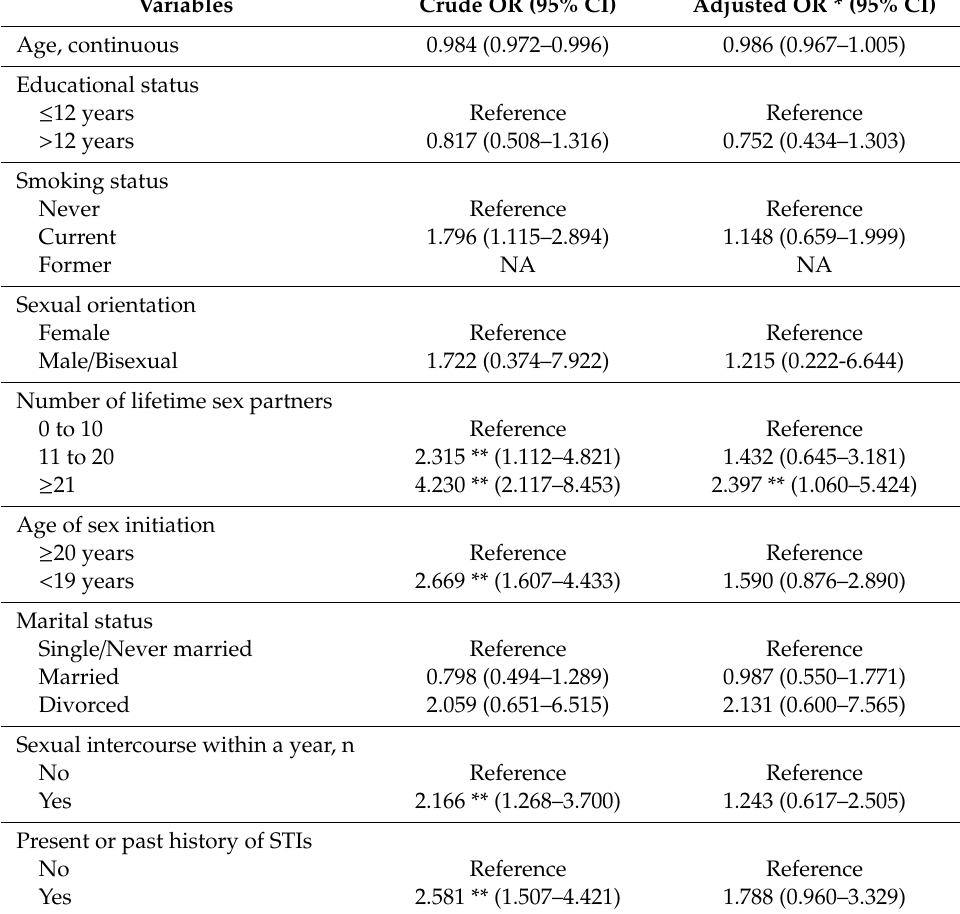
Table 6. Predictors against HPV infection targeted by the 9v HPV